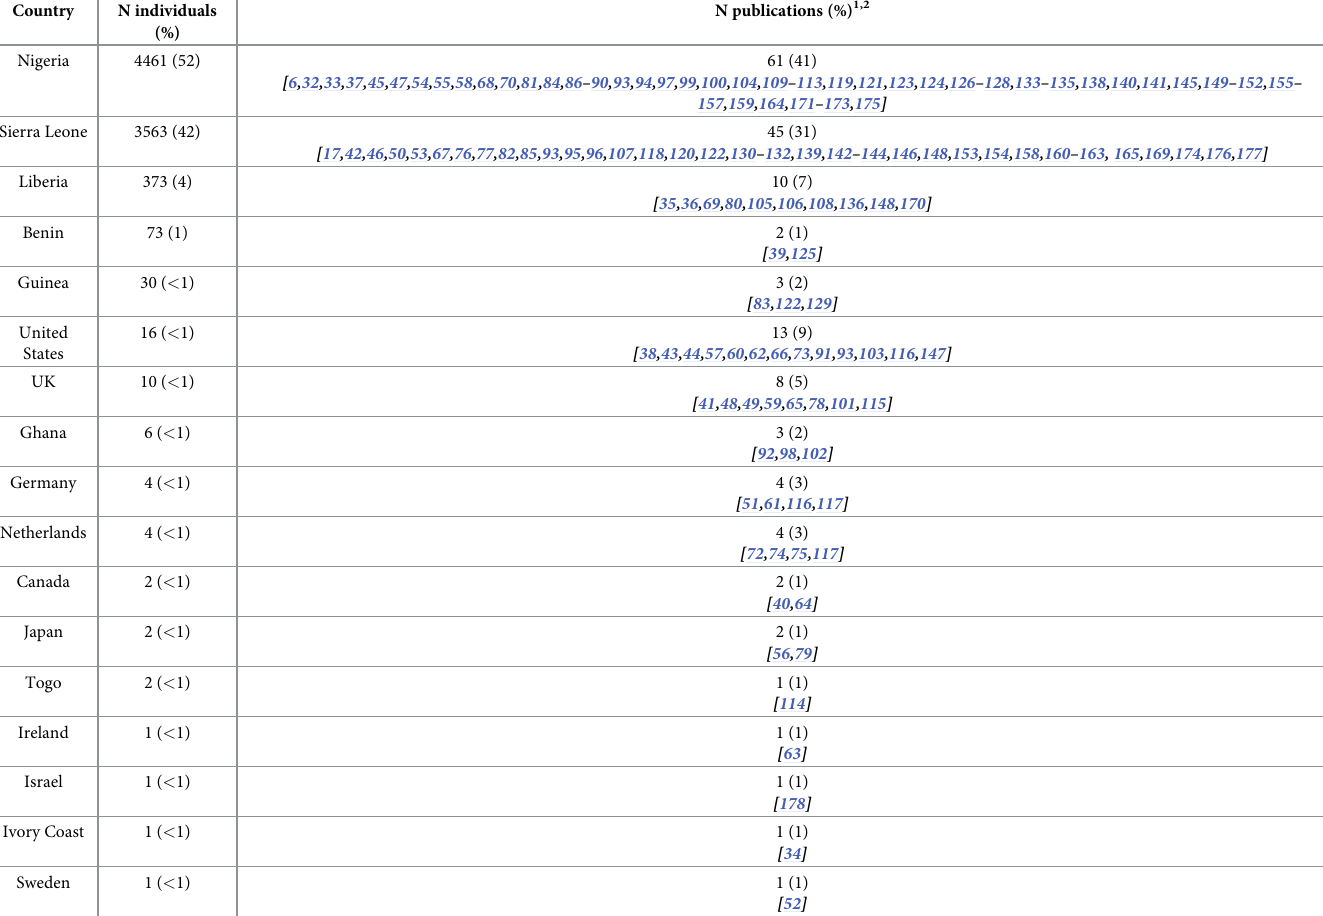
Table 2. Individuals and publications included in the systematic review per country. Country N individuals